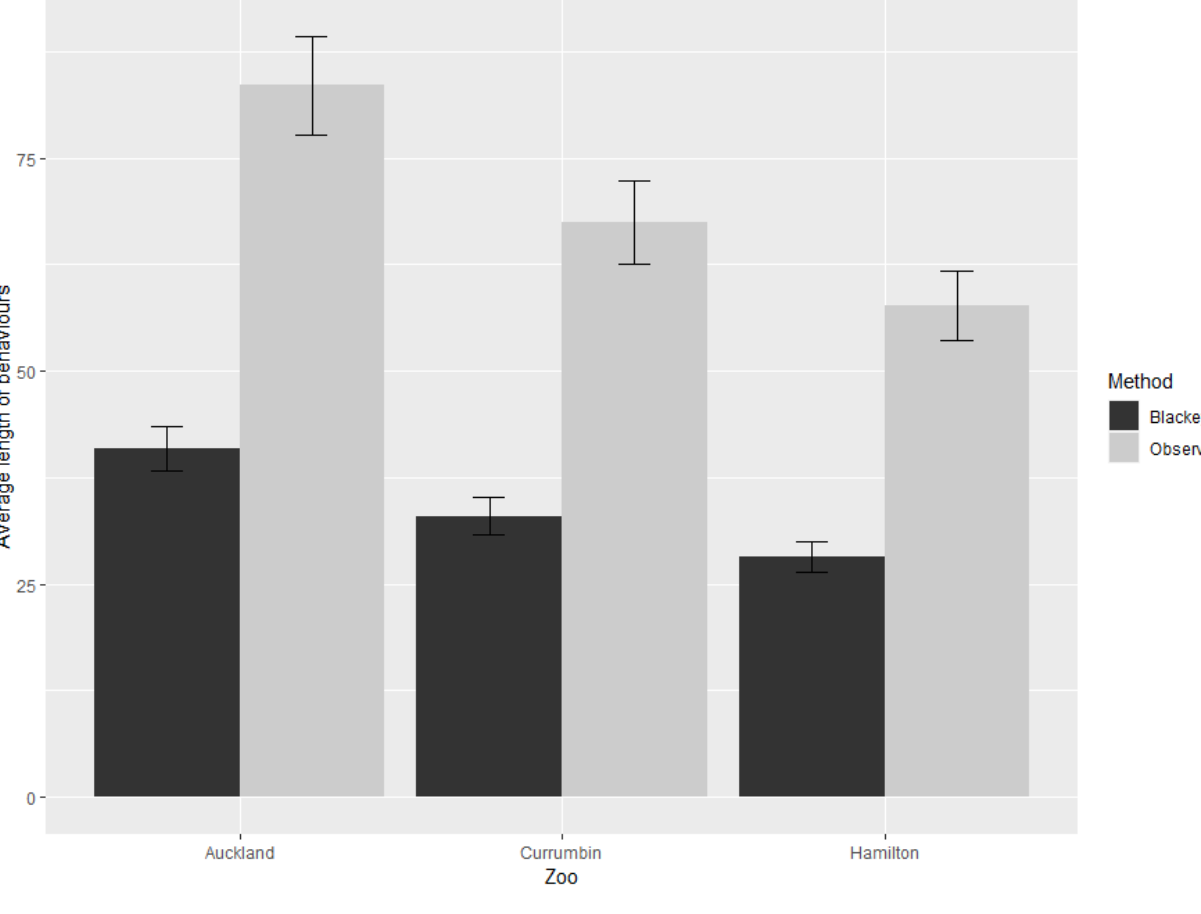
Figure 2. The average duration (response) of behaviours carried out at individual zoos by method type, as determined by Emmeans plot output as a histogram (+95 CI) v 1.4.7.